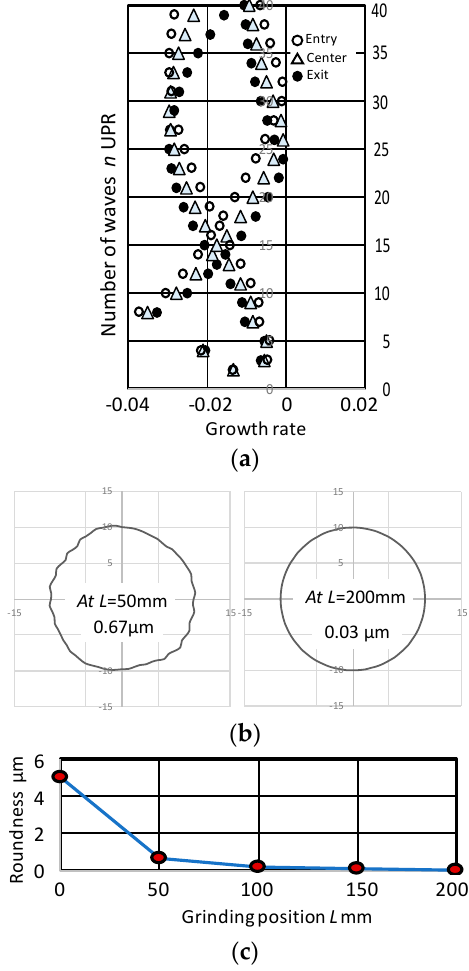
Figure 9. Simulation III: Stable process, RSI = − 0.33. ( a ) Characteristics roots; ( b ) Roundness; ( c ) Progress of roundness.